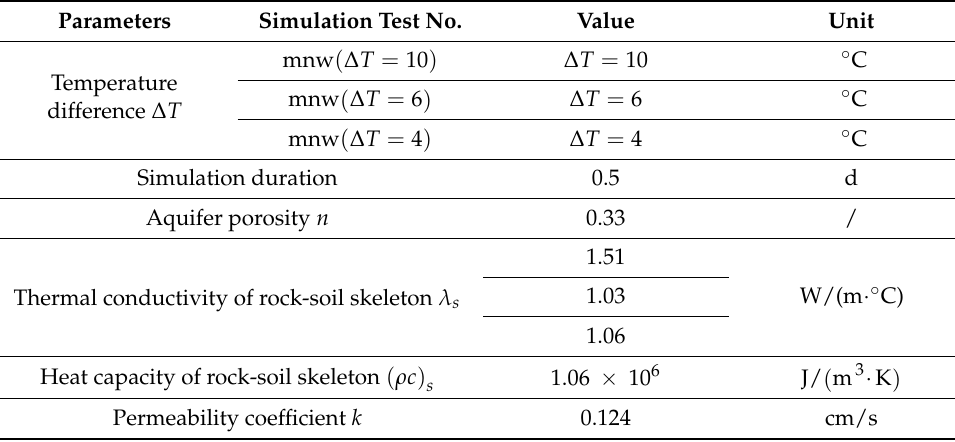
Table 5. Simulation parameter settings in the case of u = 0. Parameters Simulation Test